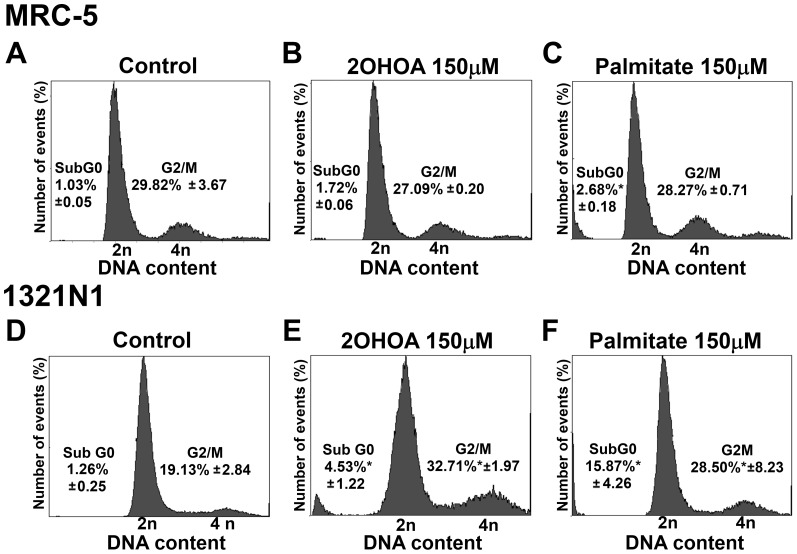
2OHOA induction of G2/M cell cycle arrest of 1321N1 cells but not of MRC-5 cells.Cell cycle assessment and G2/M phase arrest. Analysis of the DNA content (flow cytometry) of MRC-5 and 1321N1 cells exposed to 2OHOA or palmitate (150 µM for 72 hours). A. Analysis of the DNA content in untreated MRC-5 cells. B. Analysis of the DNA content in MRC-5 cells exposed to 2OHOA (150 µM for 72 h) or (C) palmitate (150 µM for 72 hours), showing the proportion of cells in Sub G0 and G2/M phases. D. Analysis of the DNA content of untreated 1321N1 cells. E. Analysis of the DNA content of 1321N1 cells exposed to 2OHOA (150 µM for 72 h) or (F) palmitate (150 µM for 72 hours), showing the proportion of cells in Sub G0 and G2/M phases. Statistical analysis of the DNA content of 1321N1 cells exposed to 2OHOA or palmitate (150 µM) revealed a significant increase (*p<0.05; n = 6) in the G2/M phase peak when compared with untreated cells (C-). No significant differences in Sub G0 values were detected in MRC-5 cells exposed to 2OHOA (150 µM)) when compared with untreated cells (C-).